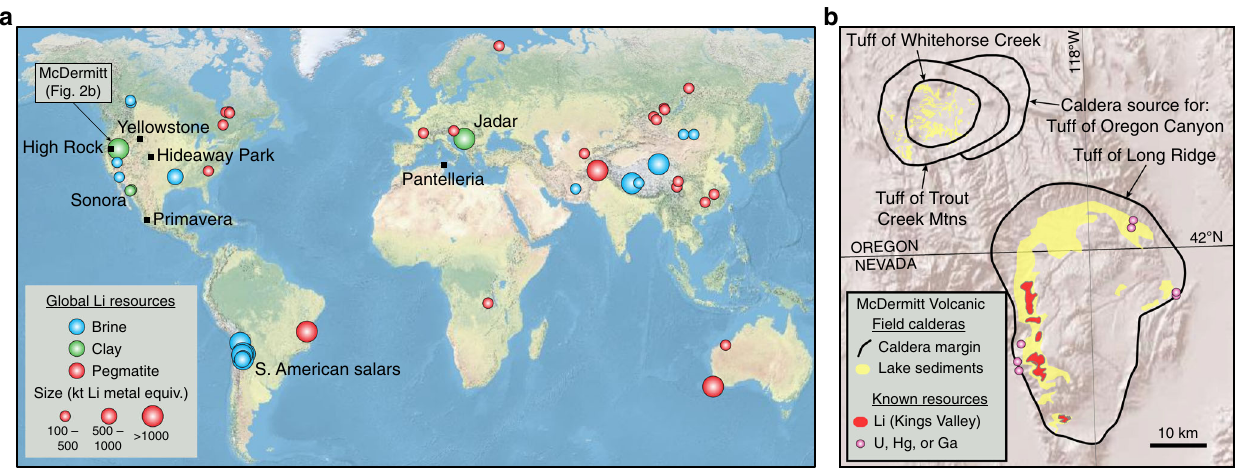
Fig. 2 Location maps of global lithium resources and McDermitt Volcanic Field. a Map of worldwide Li brine, clay, and pegmatite resources larger than 100 kt Li 7, 10, 15 and locations of volcanic systems analyzed in this study ( black squares ). b McDermitt Volcanic Field calderas and associated caldera-forming ignimbrites 22 analyzed in this study. Also shown are outcrops of caldera lake sediments 15, 22 and locations of the Kings Valley Li deposit and Ga, U, and